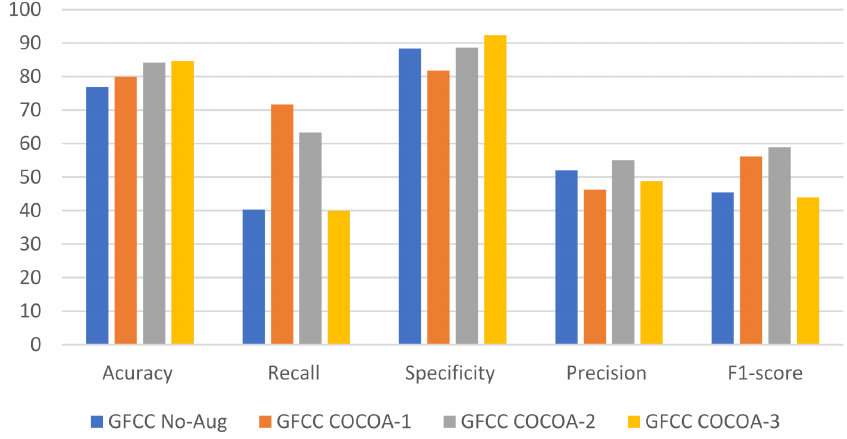
Figure 7. Comparison of performance metrics for GFCC (Healthy against positive